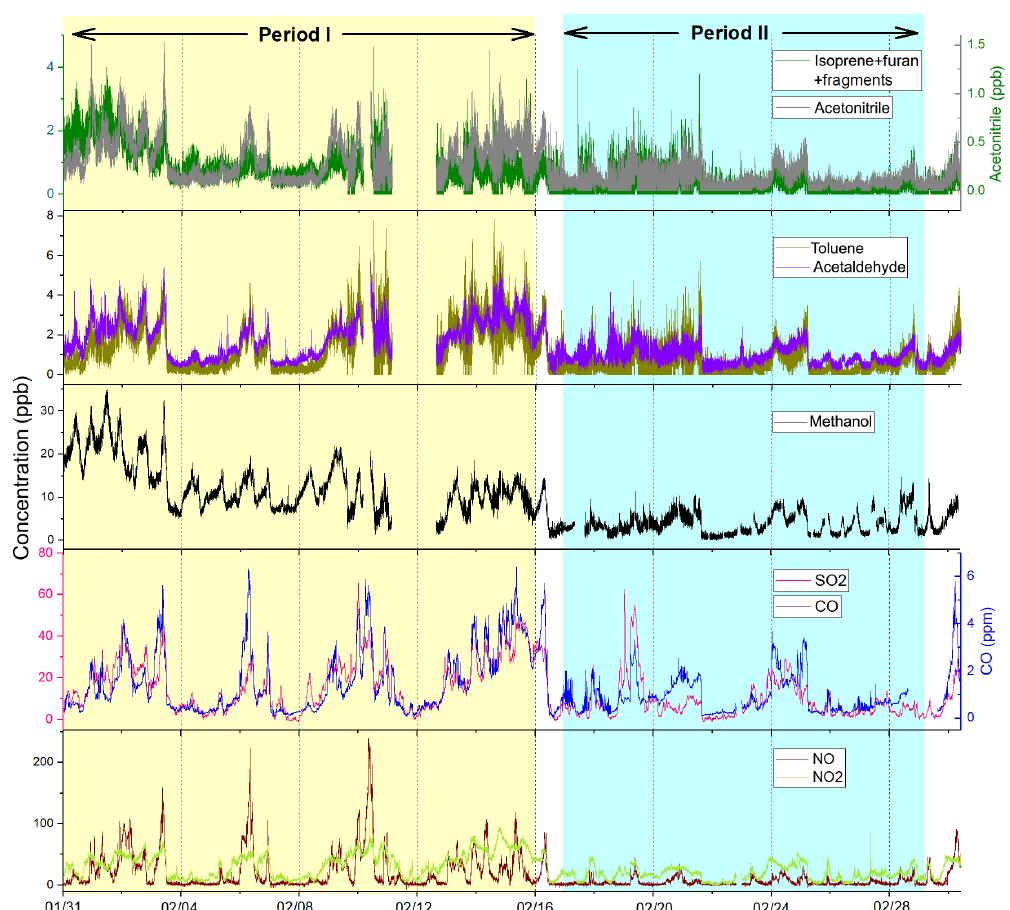
Figure 2. Time series of representative VOCs, CO, SO 2 , and NO x at the NCNST urban site. The two periods are shown: period I is the normal days, while period II is the CNY